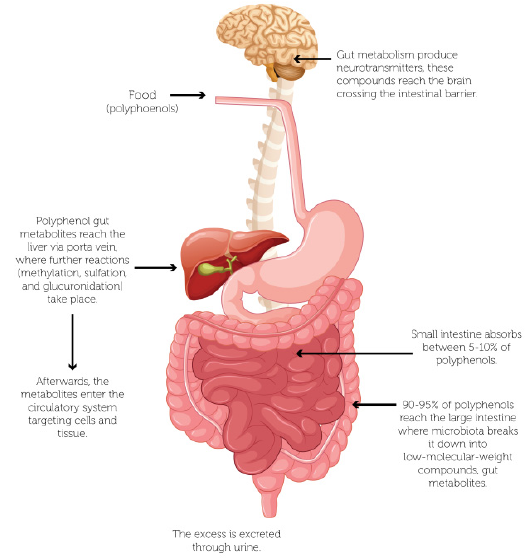
Figure 2. Helicobacter pylori colonization of the human stomach.